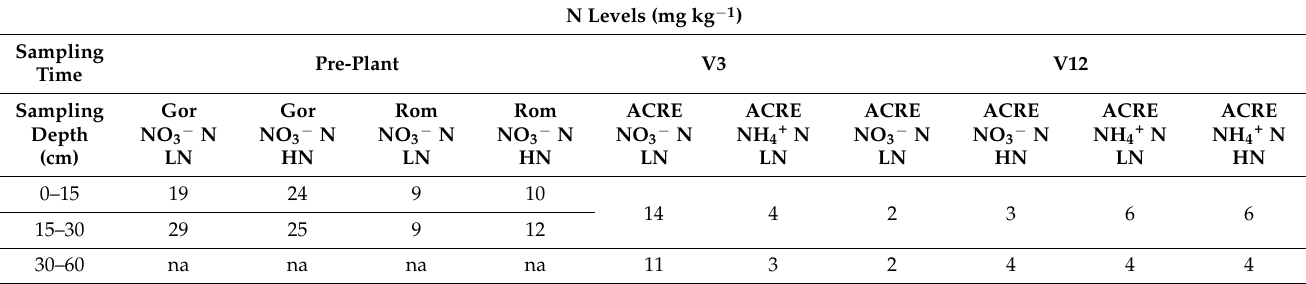
Table 2. Soil N testing